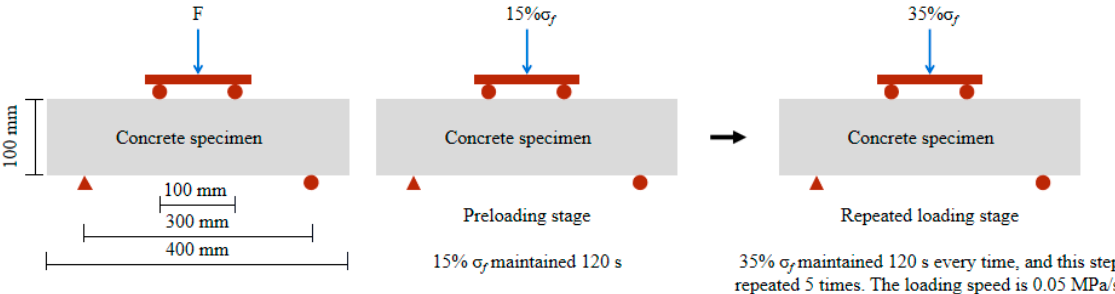
Figure 1. The specific application process is as follows: